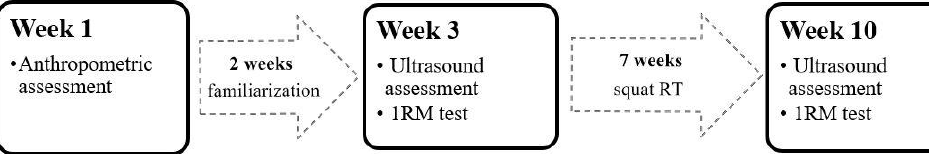
Figure 1. Flowchart of the experimental